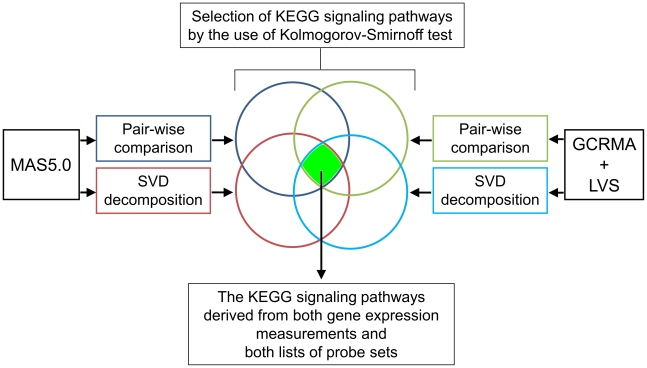
Flow chart of the steps applied to identify oncogenic signaling distinguishing between normal colon and neoplasms.To select the alternated KEGG signaling pathways, two probe-level processing procedures (MAS5.0 and GCRMA+LVS) in connection with two probe set selection and sorting criterions (pair-wise comparison and SVD decomposition) were utilized. Selection of the KEGG signaling pathways was done using the one-sided Kolmogorov-Smirnov test. To obtain the final results, KEGG intersection distinguishing between colonic epithelial cells and mucosa (Table 2) was subtracted from intersection of KEGG annotation results for whole tissue section settings computed for the both comparisons.